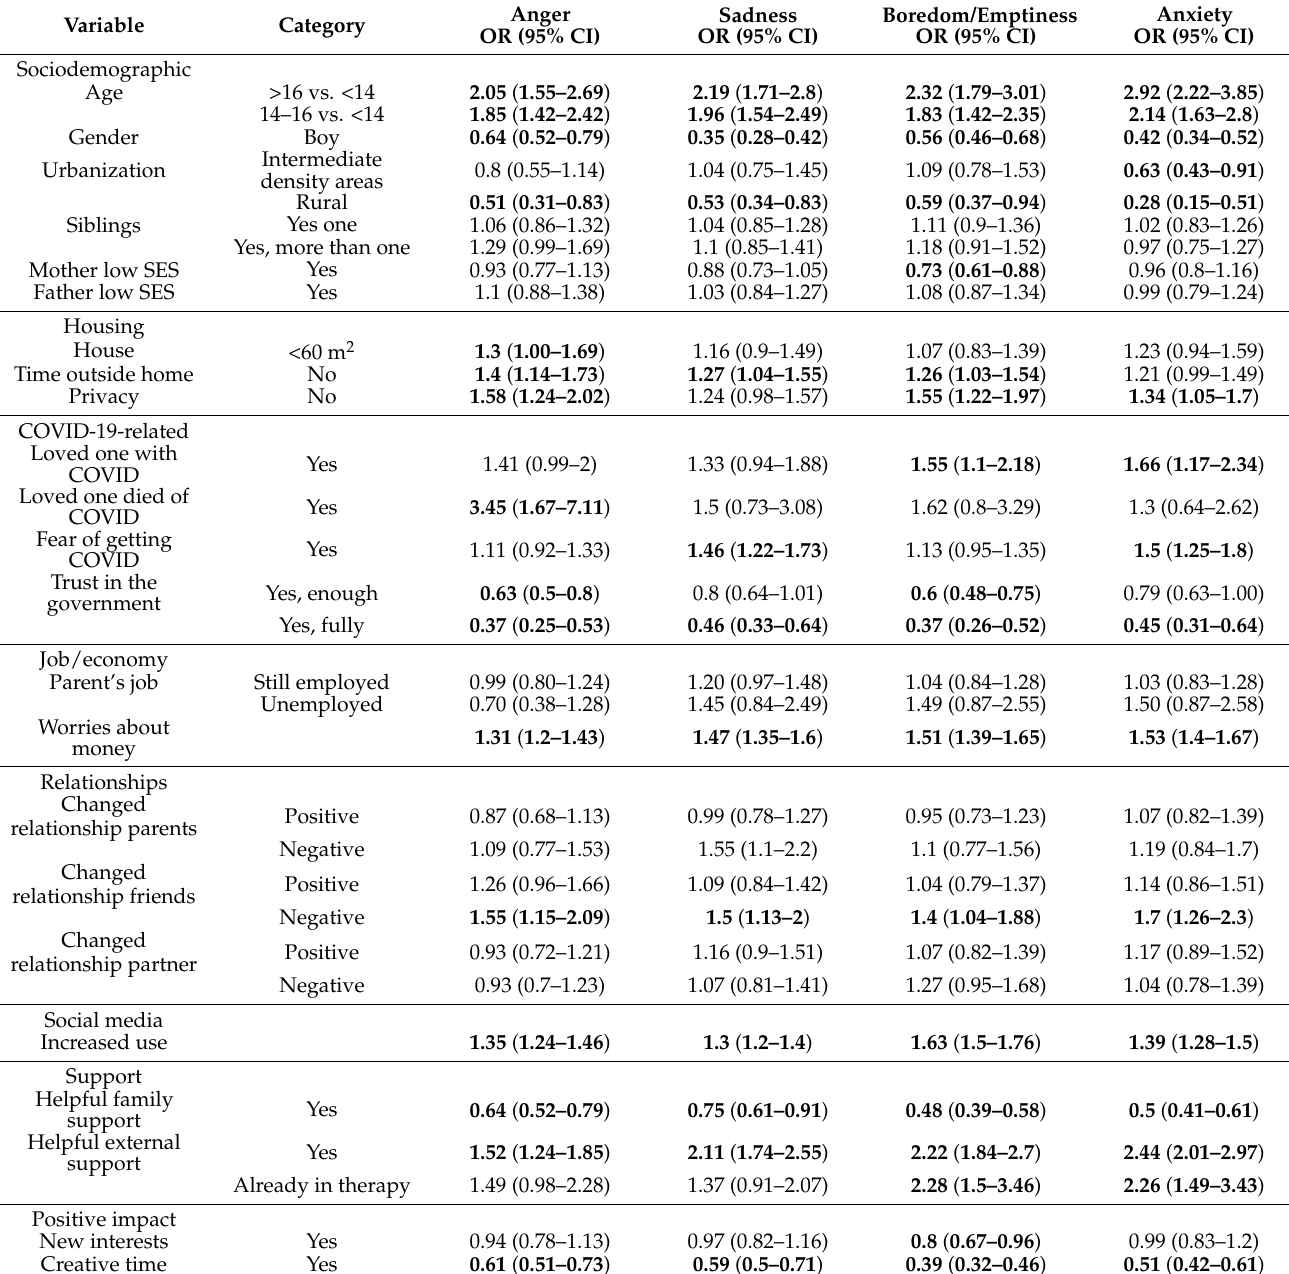
Table 2. Univariable Analysis. Logistic regression models estimating the association between each variable in column 1 and the outcomes in the last four columns (Anger, Sadness, Boredom/emptiness, and Anxiety). All analyses are adjusted for country. Boredom/emptiness has been categorized as follows: always, often = 1; never, rarely, sometimes = 0. Statistically significant variables are in